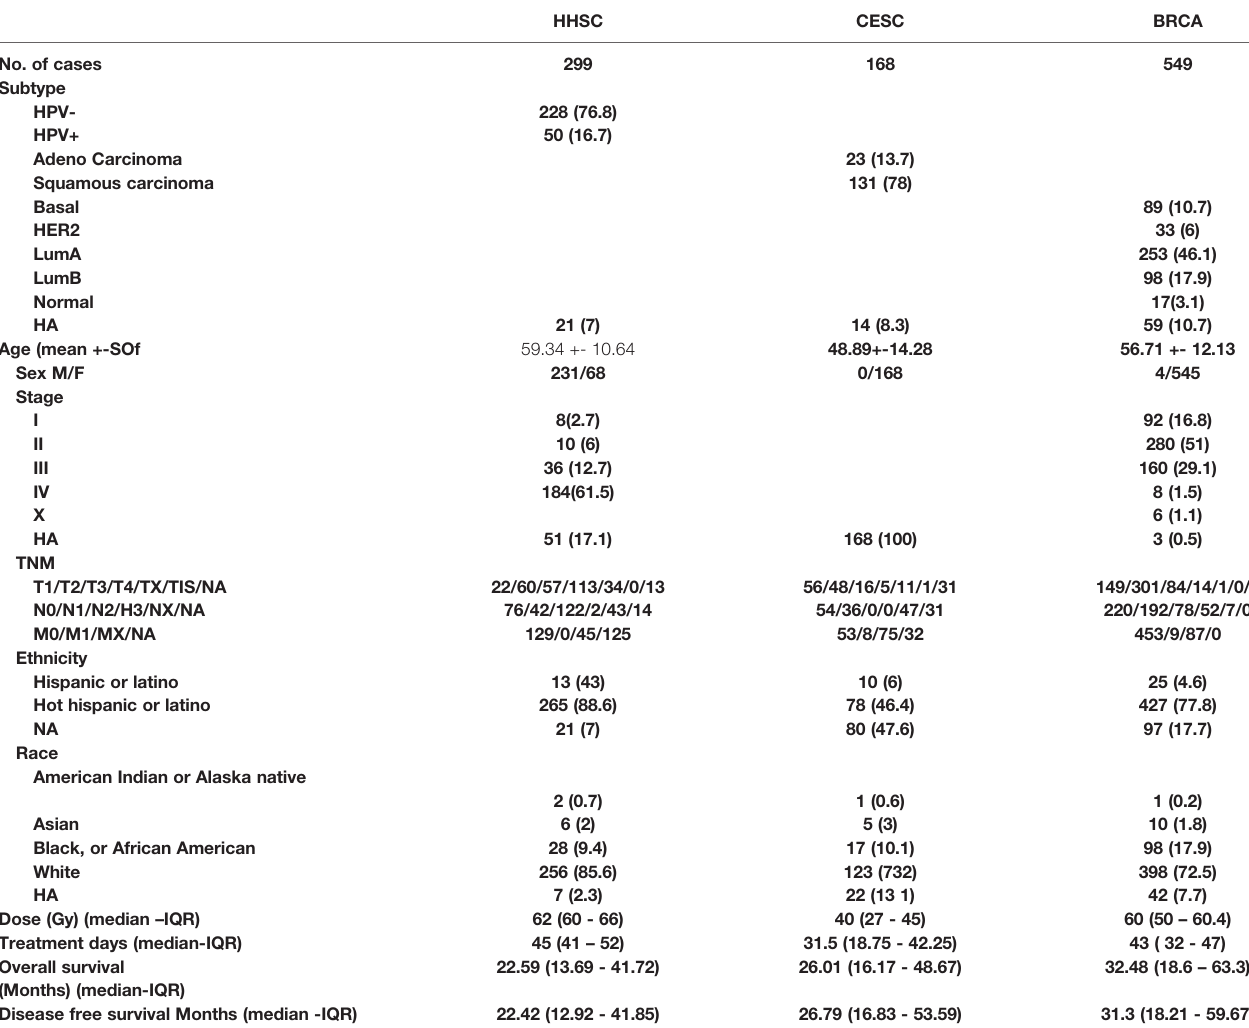
TABLE 1 | Patient